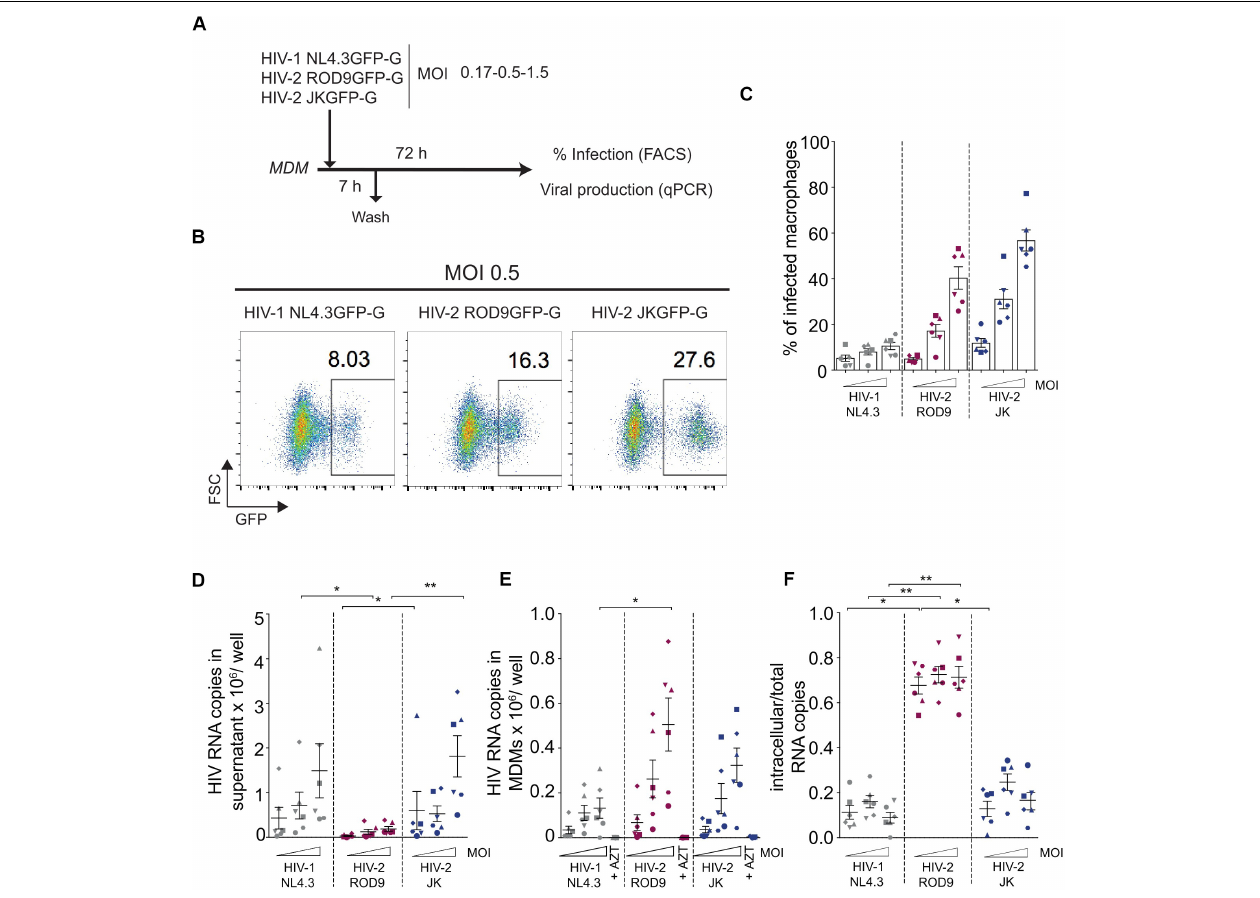
FIGURE 1 | HIV-2 infection and production of MDMs. (A) Outline of the experiment. Monocyte-derived macrophages were differentiated for 7 days with M-CSF (MDMs), infected with the indicated viruses for 7 h at different MOIs and harvested at 3 dpi for analysis of GFP expression by flow cytometry and viral genomic RNA quantification. (B) Representative dot plot analyses of infected MDMs with percentages of GFP + cells indicated in the plots. (C) Percentages of GFP + MDMs infected with the indicated viruses at 3 dpi. (D) Viral release in the supernatant and (E) Intracellular viral content at 3 dpi of MDMs evaluated by RT-qPCR. (F) Ratio of intracellular viral copies over total viral copies produced by infected MDMs. n = 6 from 3 independent experiments, individual data (each symbol representing one MDM donor across the panels) displayed with means ± standard deviations (SD). P -values were calculated using non-parametric Friedman paired test. P -values lower than 0.05 were considered as significant (* p < 0.05, ** p < 0.01, *** p < 0.001, **** p <